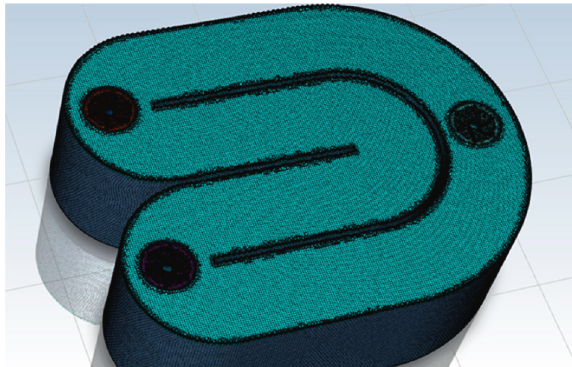
Figure 3: Grid division